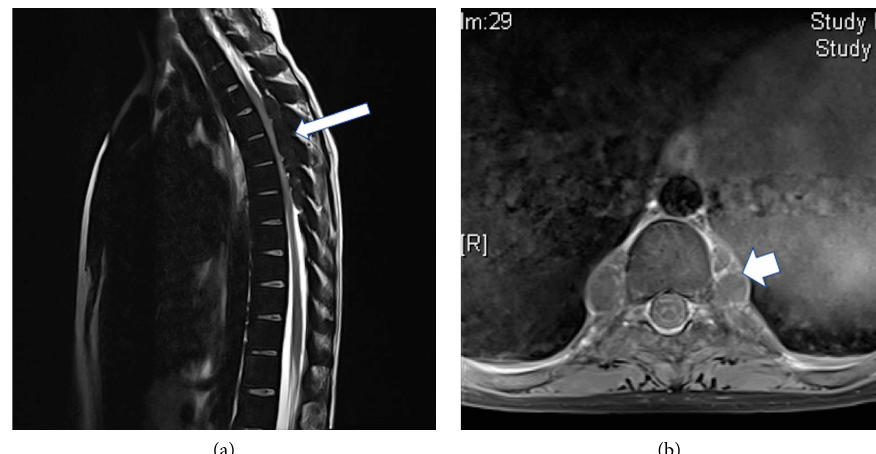
Figure 1: MRI of the dorsal spine: (a) sagittal T2-weighted, (b) axial T1-weighted images with contrast showing posterior epidural multilobulated extramedullary hematopoietic mass from T2 to T9 (arrows) with the largest at T5 causing the most prominent cord compression and showing no contrast enhancement.